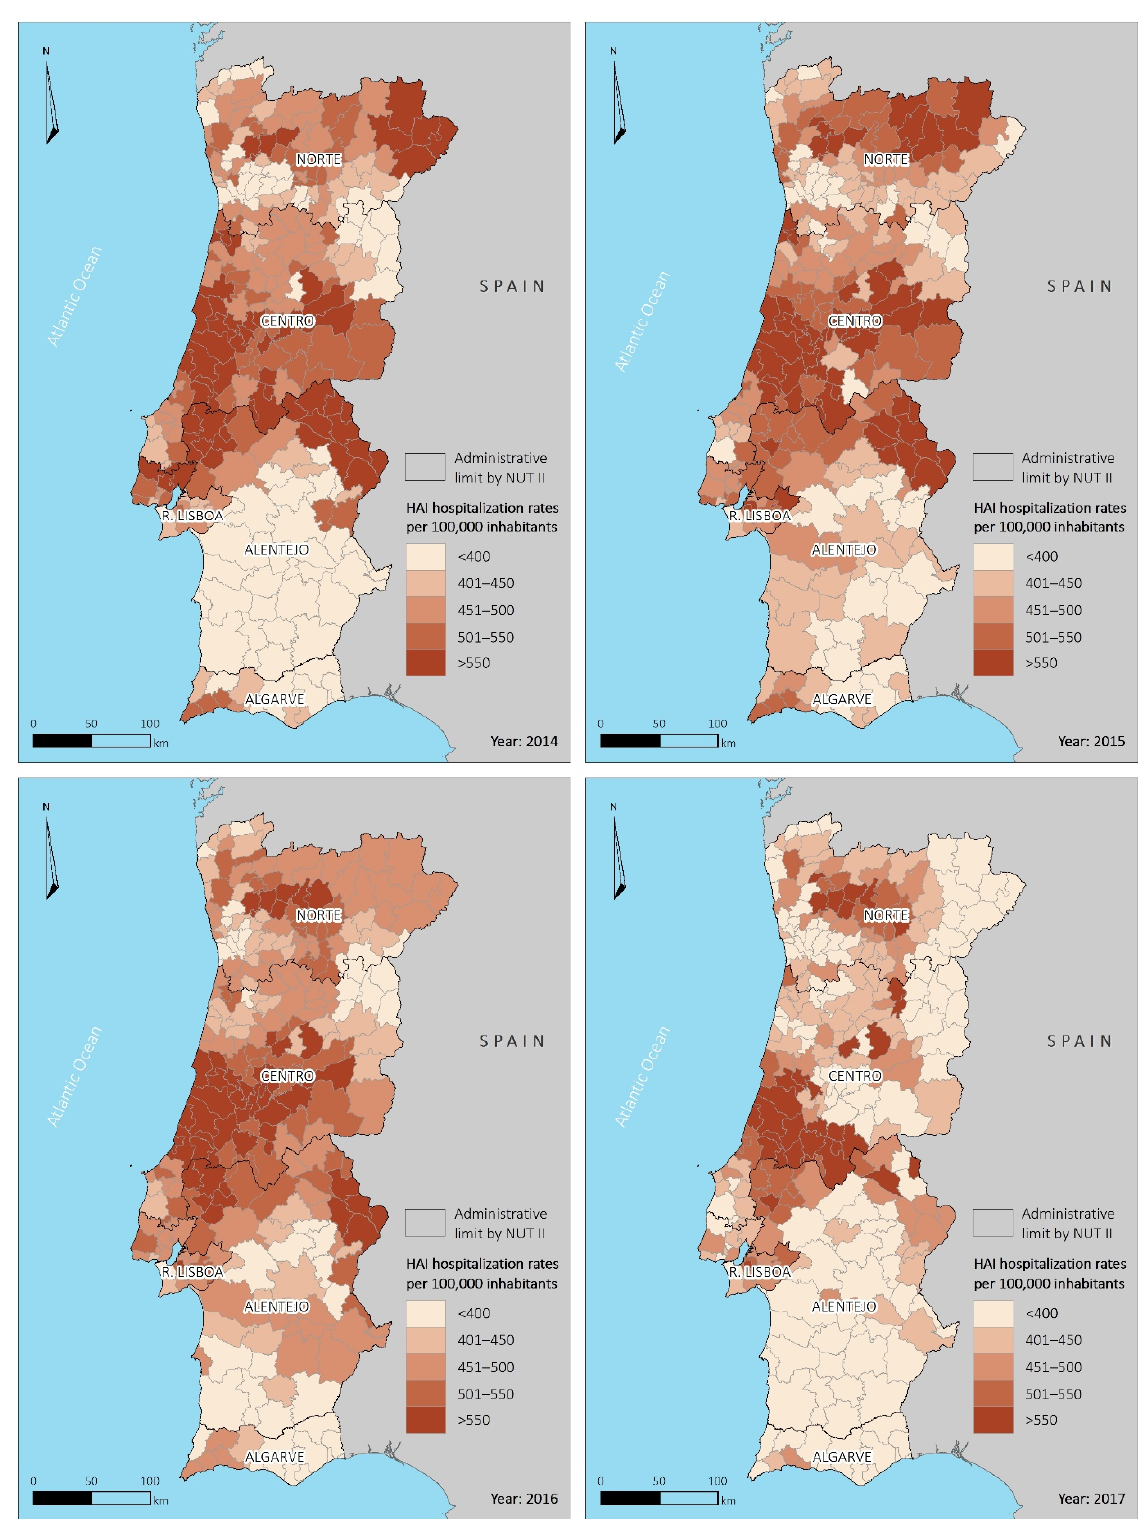
Figure 2. Spatial distribution of age-standardized HAI hospitalization rates per 100,000 inhabitants, per municipality, for the period 2014–2017.